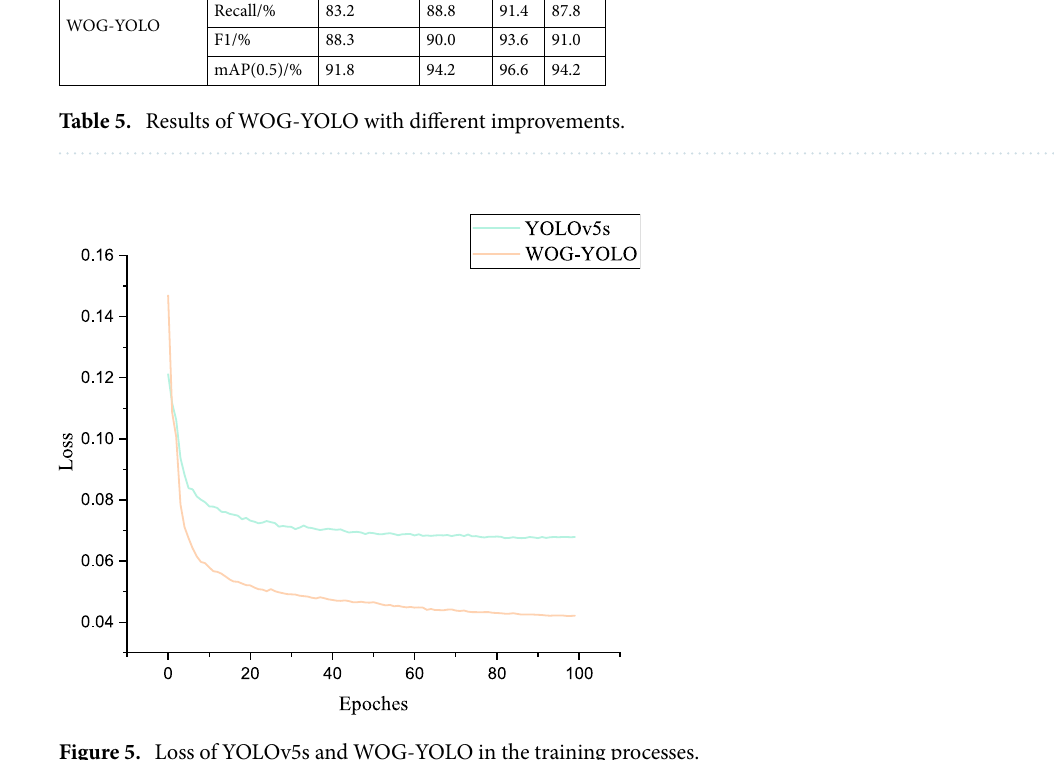
Figure 5. Loss of YOLOv5s and WOG-YOLO in the training